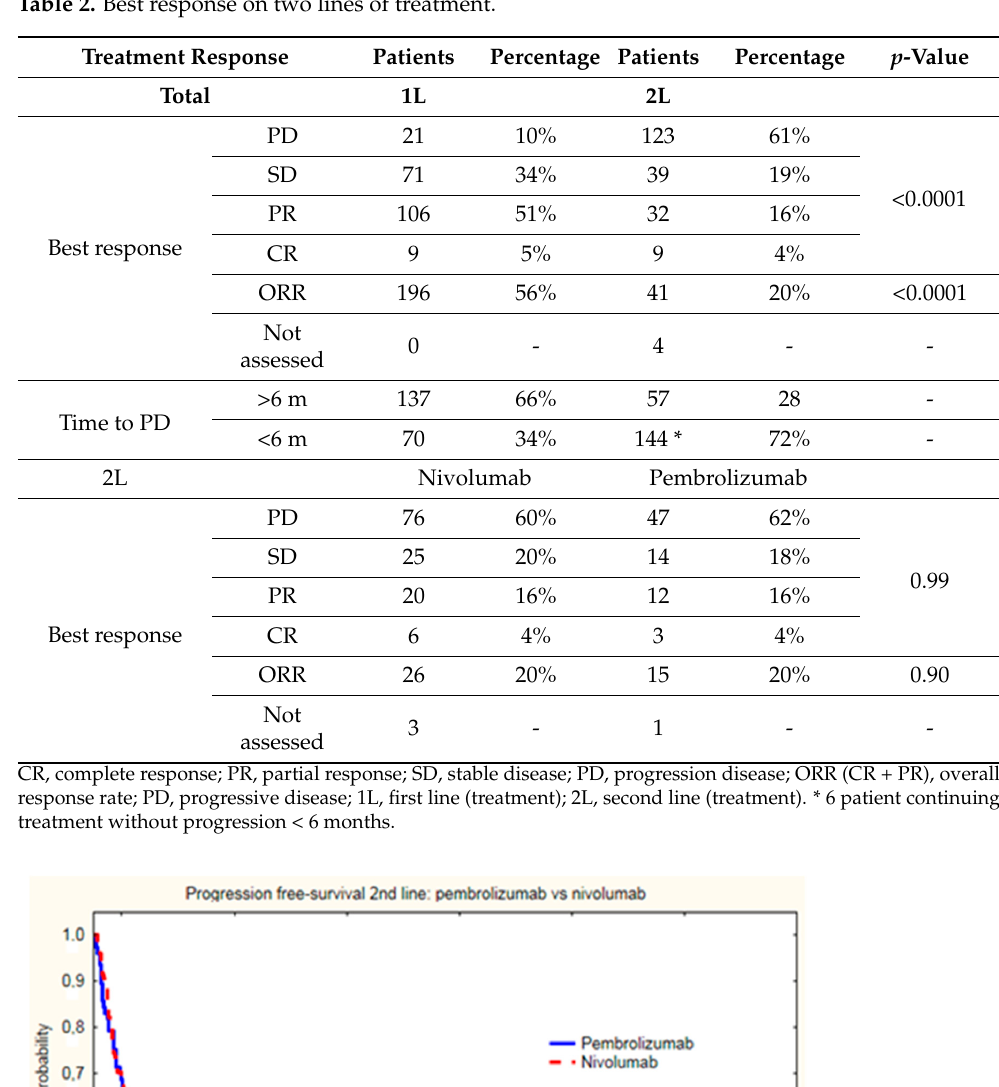
Table 2. Best response on two lines of treatment.